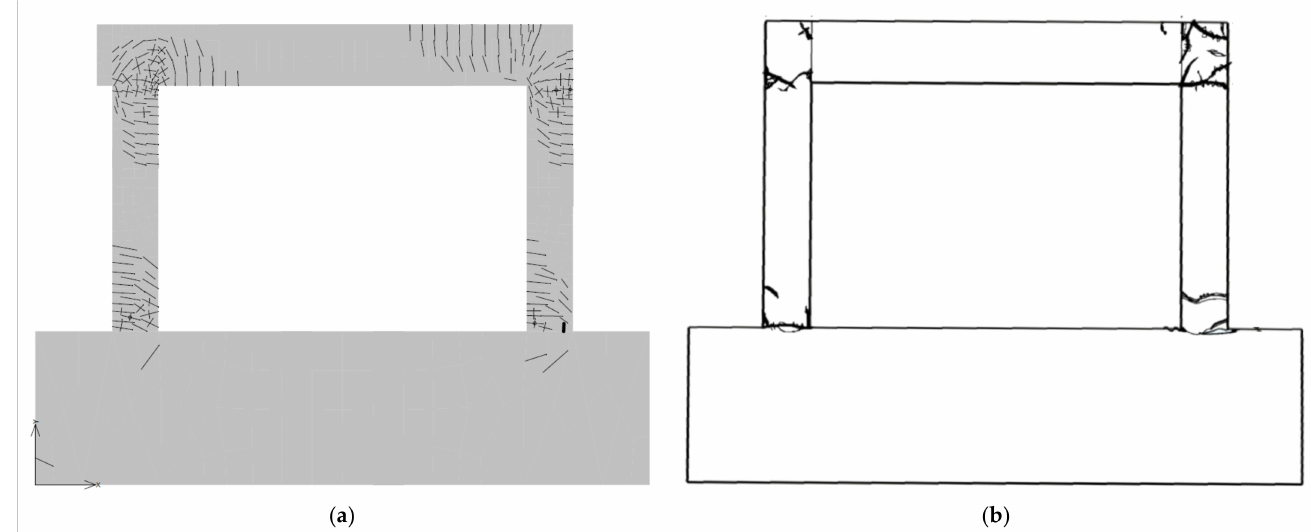
Figure 5. Comparison of cracks intensities of the FE results ( a ) and Kakaletsis’s experiment ( b ).